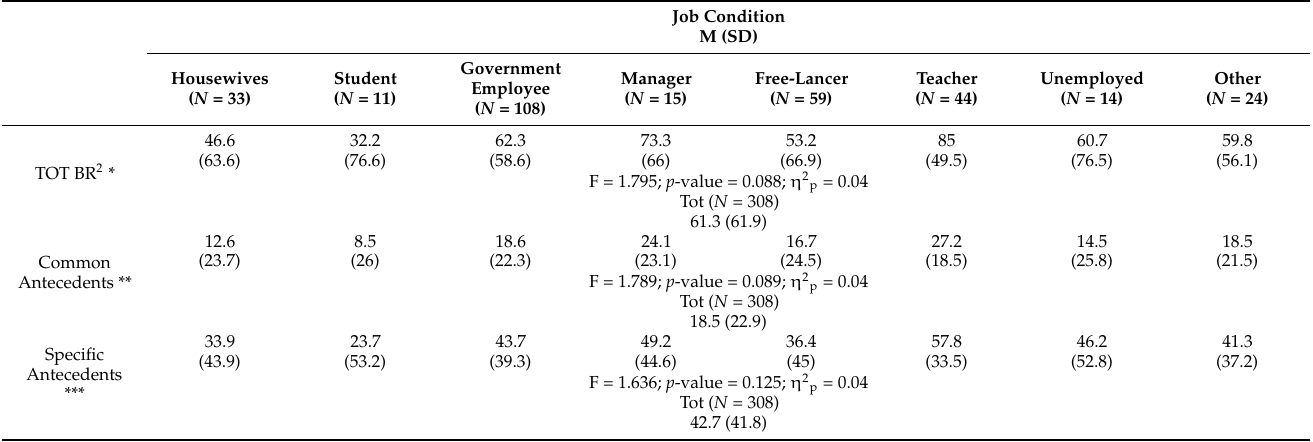
Table 4. Parental distress descriptive data for job conditions.